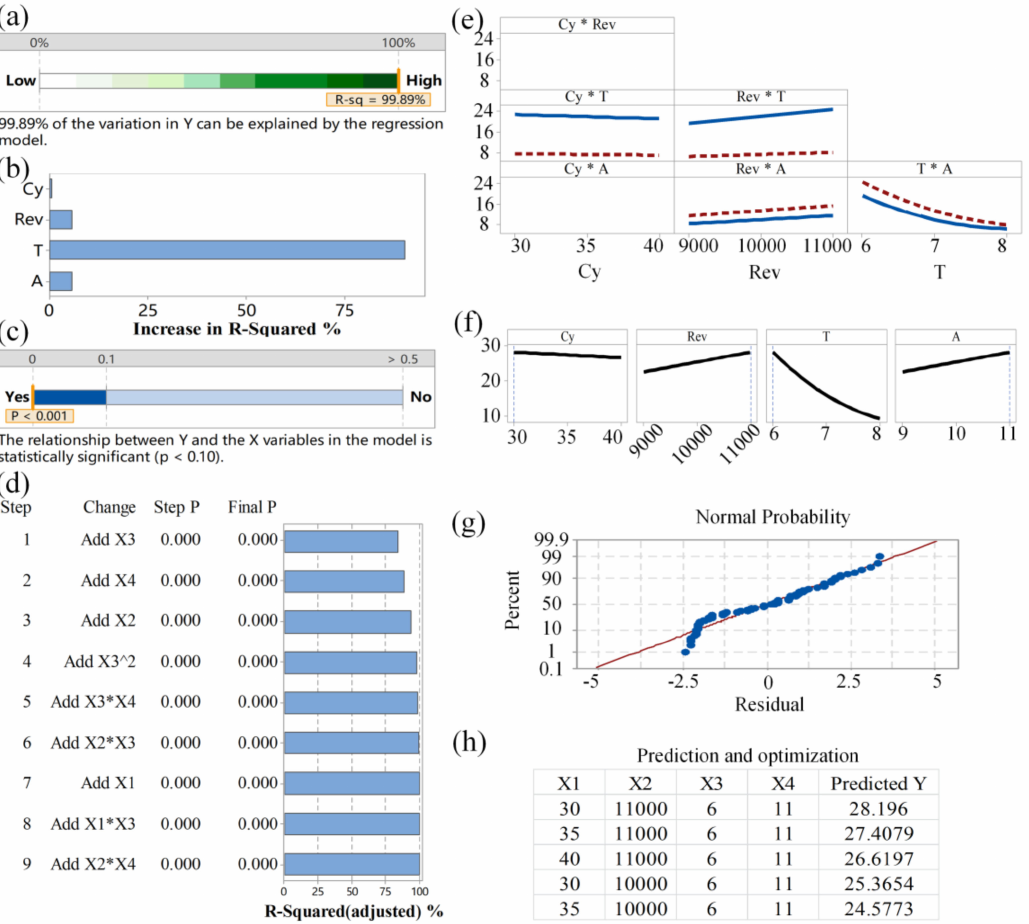
Figure 15. Multiple regression analysis and power prediction: ( a ) R-sq report; ( b ) contribution of each parameter in R-sq; ( c ) P value; ( d ) R-sq (adj) report; ( e ) parameter interactive analysis; ( f ) influence of parameters on output; ( g ) residual analysis; ( h ) prediction and optimization